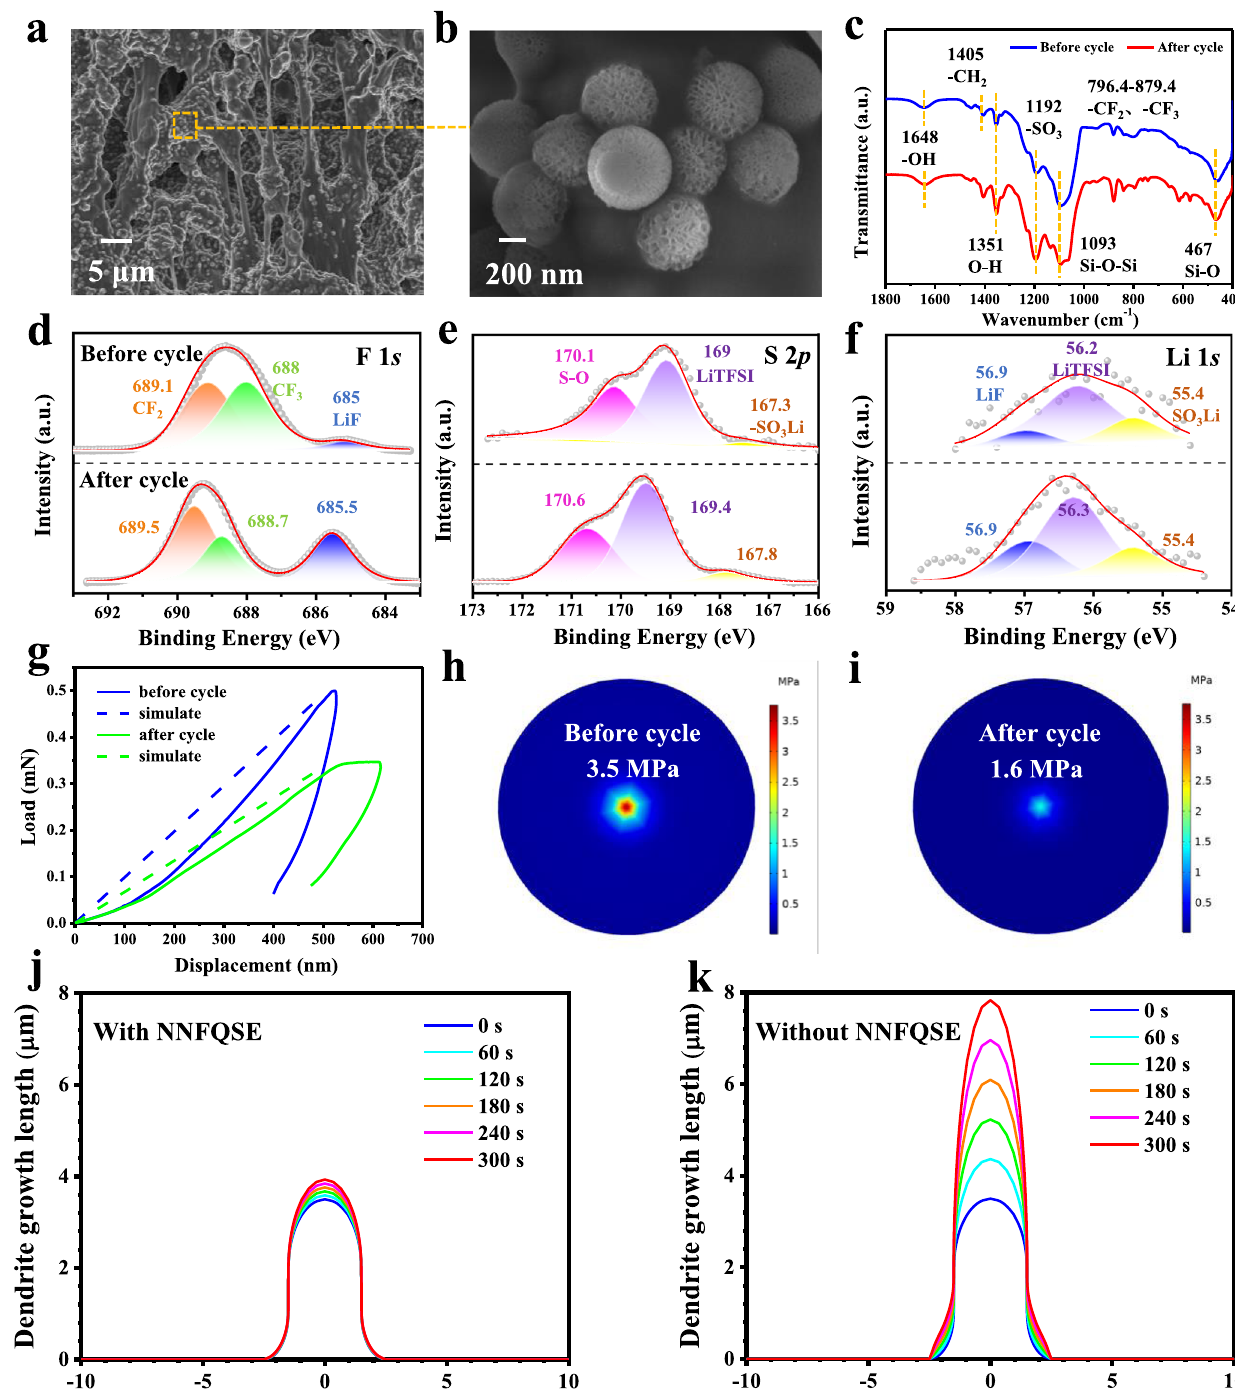
Fig. 5 | Characterization of NNFQSE SiO 2 -SO 3 Li/PVDF-HFP before and after 5000h cycling. a Cross-section SEM images; b enlarged view of a ; c Infrared spectrum among the region of 400 – 1800cm − 1 ; XPS analysis: d F 1 s ; e S 2 p ; f Li 1 s ; g Nano-indentation test and simulated load-displacement curve. The horizontal coordinate corresponds to lithium dendrite length, and the vertical coordinate